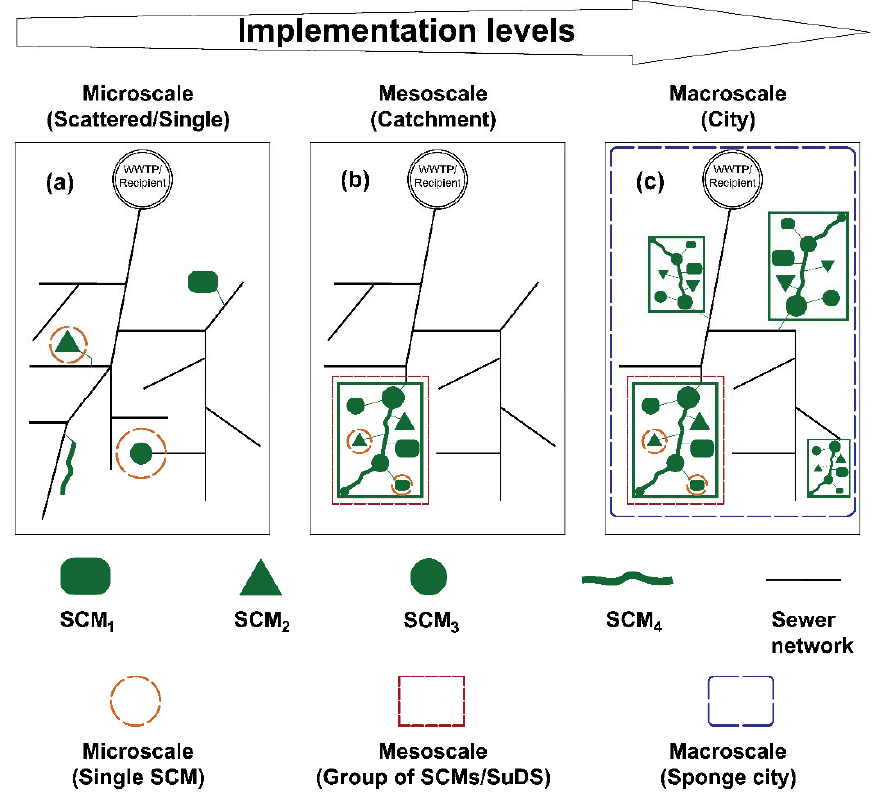
Figure 1. Different levels of implementation for SuDS/SCMs, ( a ) Microscale, ( b ) Mesoscale, and ( c ) Macroscale.